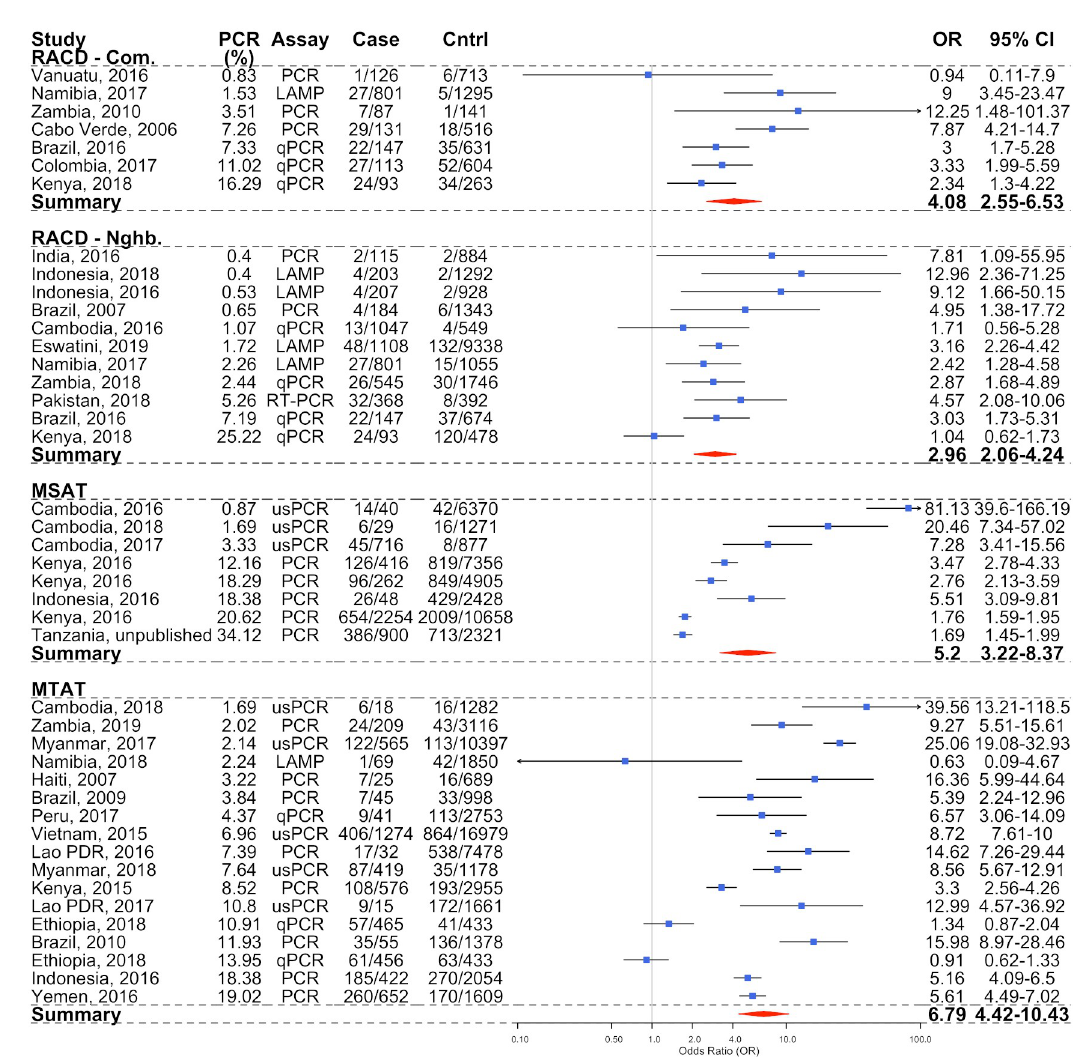
Fig 3. Forest plot showing the OR of PCR-detectable infections within case compared to control households (blue circles, and OR column), stratified according to the detection strategy. RACD according to community and neighbour control populations, MSAT, and MTAT with the 95% CIs are shown in the black lines for each OR and in the 95% CI column. The pooled OR statistics for each strategy, as calculated according to a random effects model, with study site as the random effect are shown as red diamonds, with the width representing the 95% CI. Studies are listed in ascending order of malaria PCR prevalence in the community. LAMP, loop mediated isothermal amplification; MSAT, Mass Screen and Treat; MTAT, Mass Test and Treat; OR, odds ratio; PCR, polymerase chain reaction; qPCR, quantitative PCR; RACD, Reactive Case Detection; usPCR, ultra-sensitive